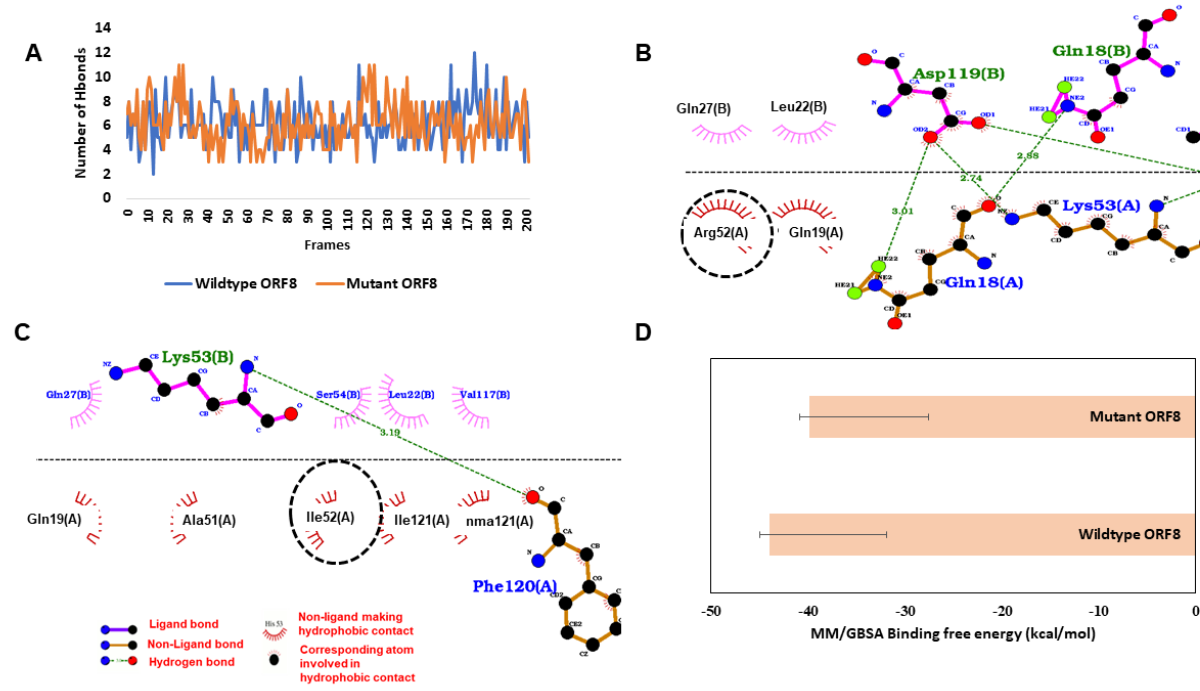
Figure 5. Binding affinity between ORF8 protomers. ( A ) The number of hydrogen bonds between the wildtype (WT) and mutant (MT) ORF8 protomers during the simulation. ( B ) Wildtype ORF8 interactions in the average structure extracted from MD simulations, R52 (circled) making hydrophobic contact (hydrogen bonds are shown with green dots and non-polar interactions with magenta and brick semicircle). ( C ) Mutant ORF8 interactions in the average structure. ( D ) MM/GBSA binding free energy in kcal/mol.